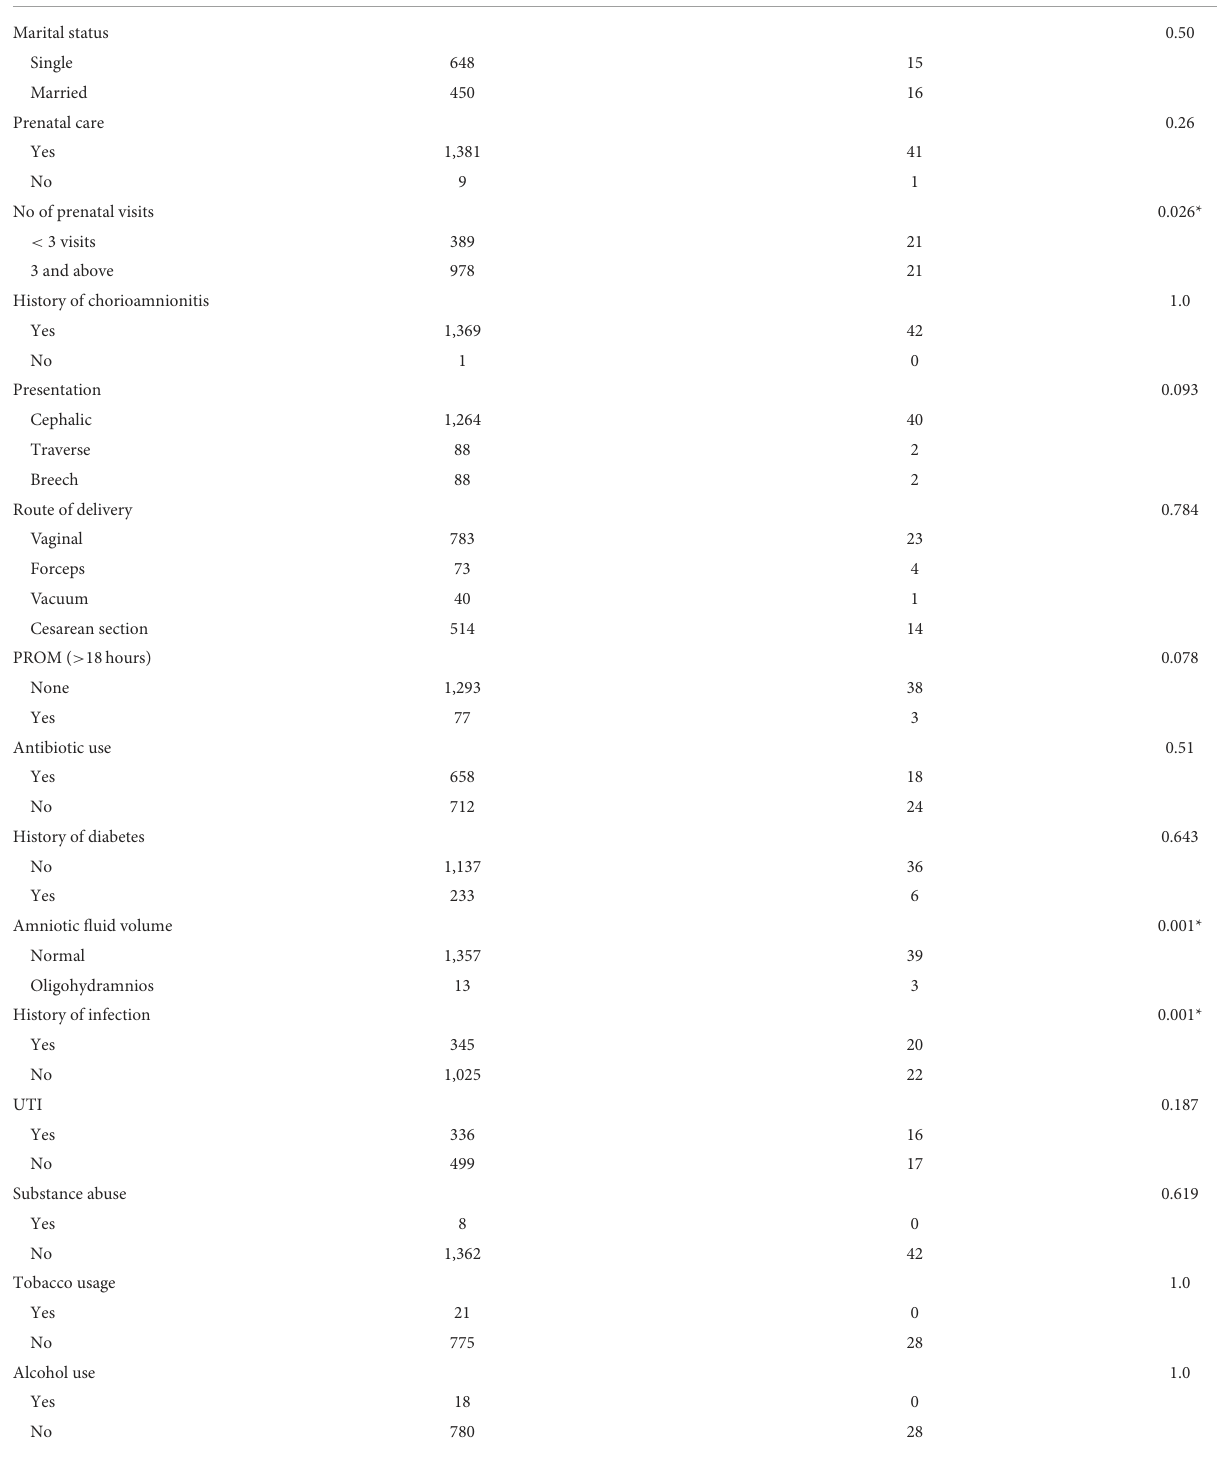
TABLE 5 Association of maternal characteristics and significant hyperbilirubinemia at the 72nd HOL. Characteristics No Significant hyperbilirubinemia at 72 nd HOL Significant hyperbilirubinemia at the 72